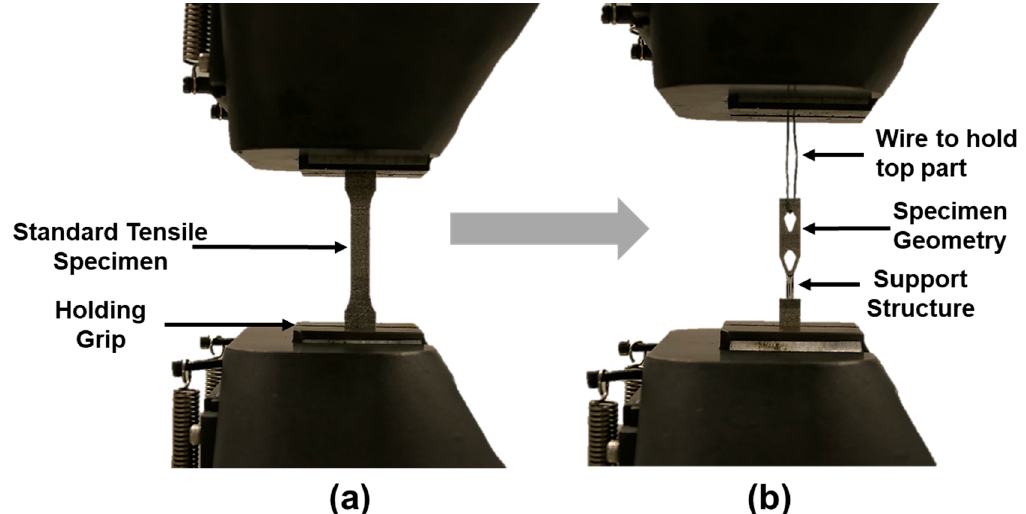
Figure 2. ( a ) Standard tensile testing setup and ( b ) modified test setup, used for measuring the breaking load requirements of support structure designs.